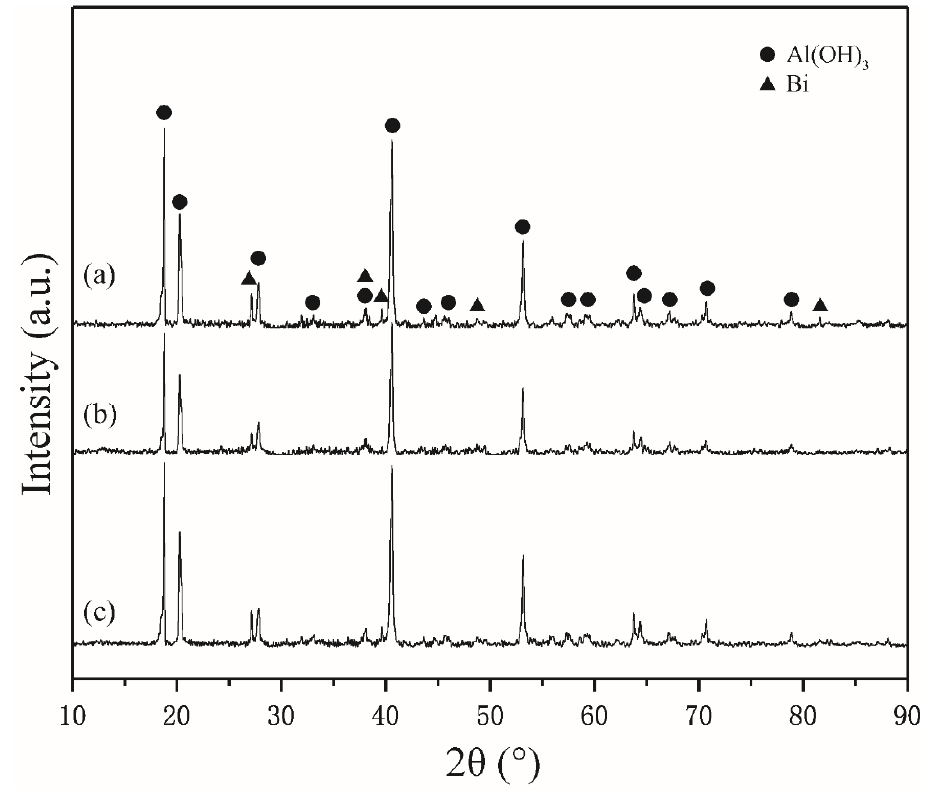
Figure 7. XRD patterns of Al–Bi–Sn–Cu powders hydrolysis products: ( a ) Al–10Bi–7Sn–0.5Cu, ( b ) Al–10Bi–7Sn–1.5Cu, ( c ) Al–10Bi–7Sn–3Cu.